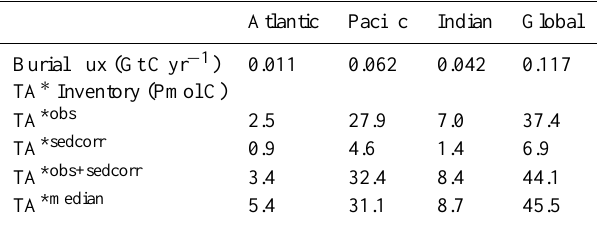
Table 3. Mean sediment burial fluxes (Gt Cyr − 1 ) and observation- based vs. simulated TA ∗ inventories (PmolC). TA ∗ sedcorr is esti- mated as the mean difference in TA ∗ between runs with and runs without the sediment module across the 14 best Bern3D simula- tions. The median estimate is from the constrained 1000-member ensemble (without the sediment